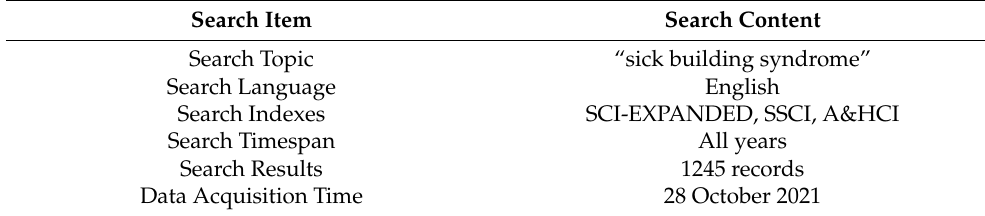
Table 1. Search information in SBS domain.